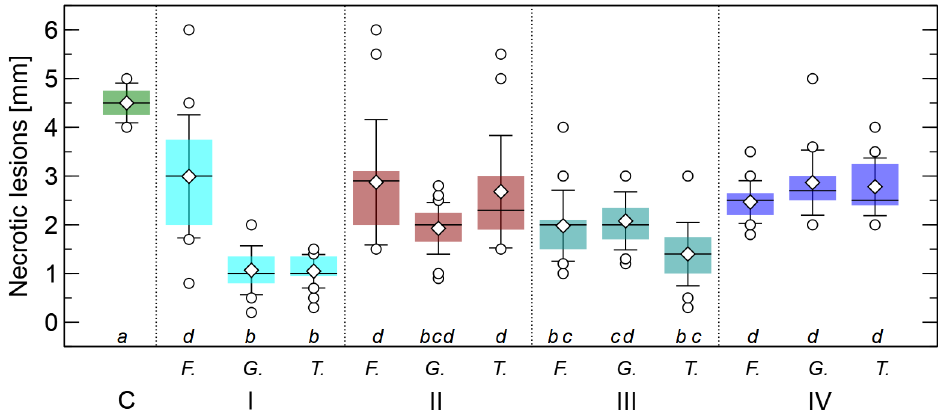
Figure 5. Necrosis length for various extracts: C–control, F. – Fomitopsis pinicola , G. – Ganoderma applana- tum , T. – Trametes versicolor and various extracts treatments (I—IV). Treatments, for which statistically significant difference at p < 0.05 was found using Tukey’s multiple comparisons test, are marked by different characters in the bottom part of the